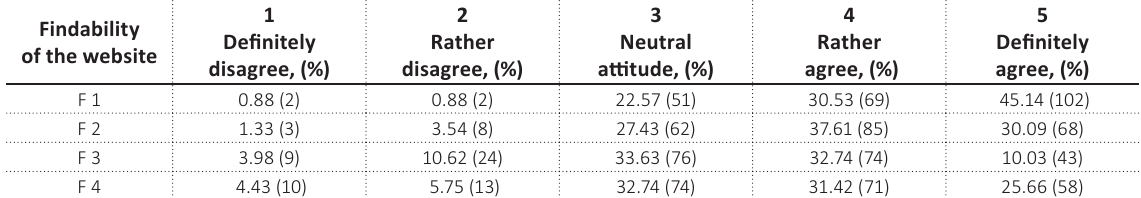
Table 2. Navigation factor of the website